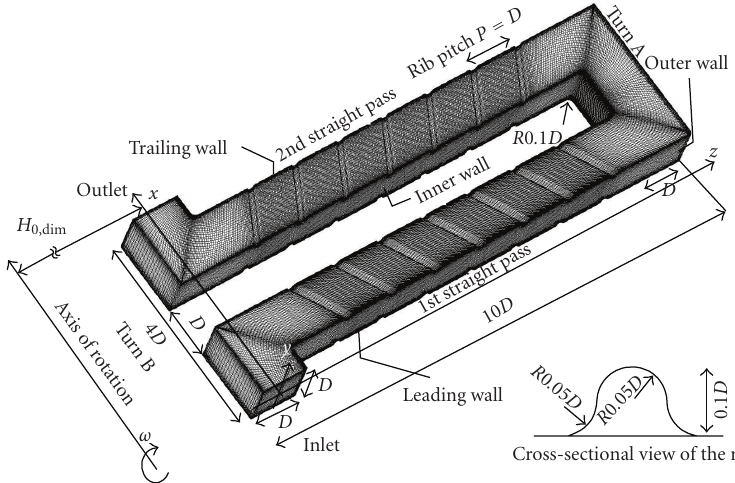
Figure 1: Schematic of a rotating two-pass rib-roughened square channel with sharp 180 ◦ turns (60 ◦ rib with NP arrangement).